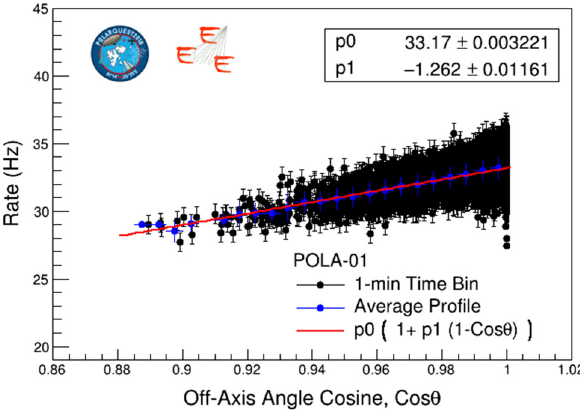
Fig. 19 POLA-01 rate as a function of the cosine of the angle between the vertical and the axis perpendicular to the top surface of the